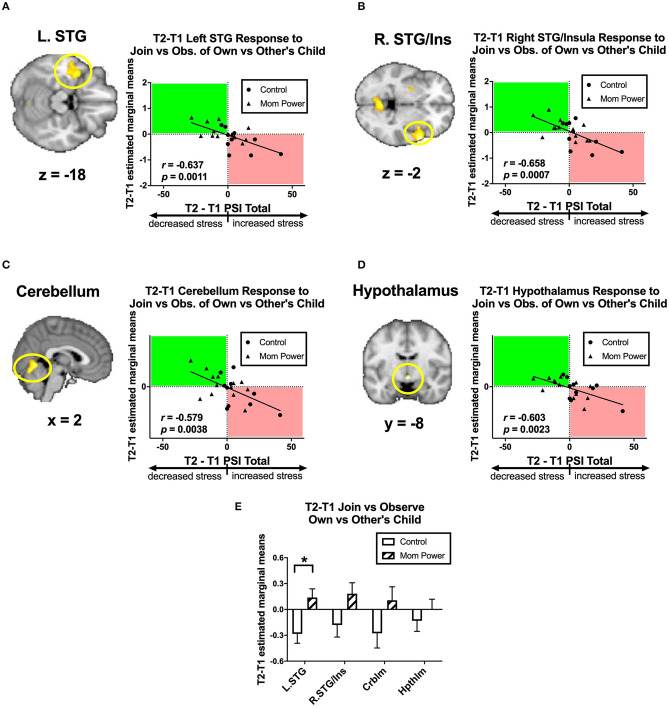
From T1 to T2 in the clinical study sample, the T2-T1 differences in parenting stress index (dPSI) were negatively associated with the concomitant increases in the MMR(all) [Join[Own vs. Other Child] vs. Observe[Own vs. Other Child]] differential responses in the left superior temporal gyrus (STG) (A), right STG/insula (B), cerebellum (C), and hypothalamus (D), each with the dPSI depicted on the x-axis, against the T2-T1 difference in the region's differential response on the y-axis, in the scatter plots. The Pearson's correlation r scores and p-values are embedded in the plots. The bar charts of each region's mean (±s.e.) are depicted in (E). *p < 0.05.